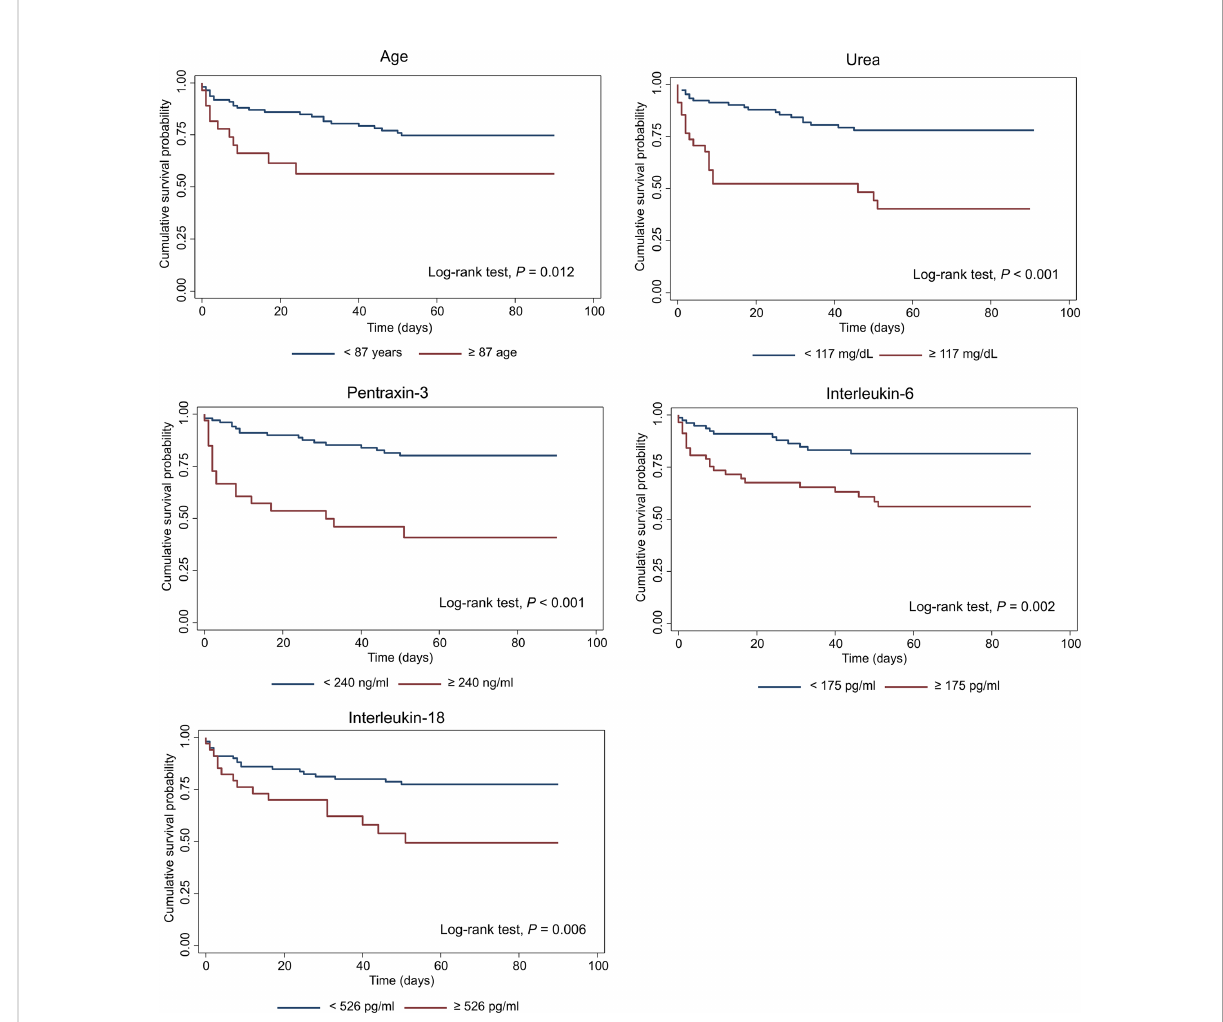
FIGURE 3 Kaplan-Meier survival curves of predictors included in the multivariable Cox model of 90-days mortality. Patients were categorized in two groups in accordance to continuous predictors dichotomized based on the maximally selected rank statistic. PTX3, IL-6 and IL-18 were log10- transformed before analysis. For each predictor, survival was analyzed by Log-rank test and correspondent p values are reported on the graphs.